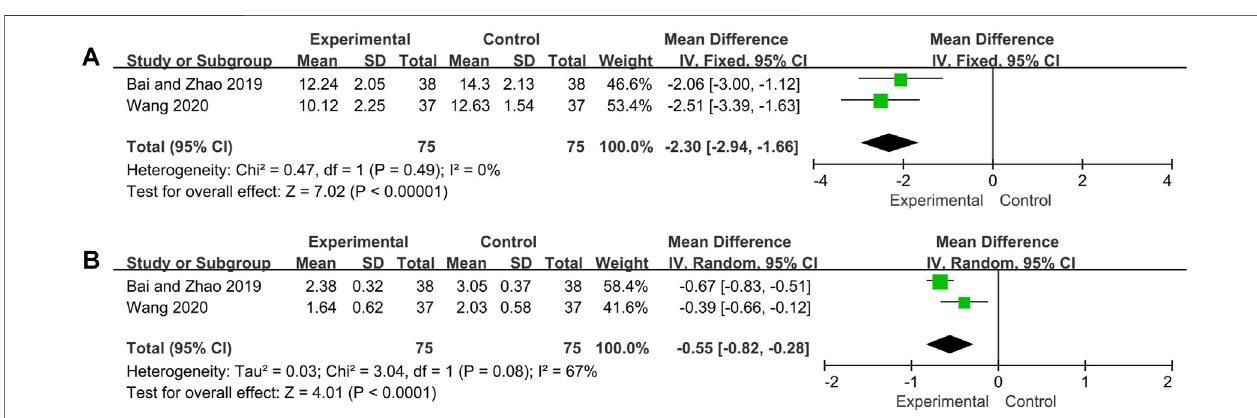
FIGURE 6 | Forest plot of IgG (A) and IgA (B)